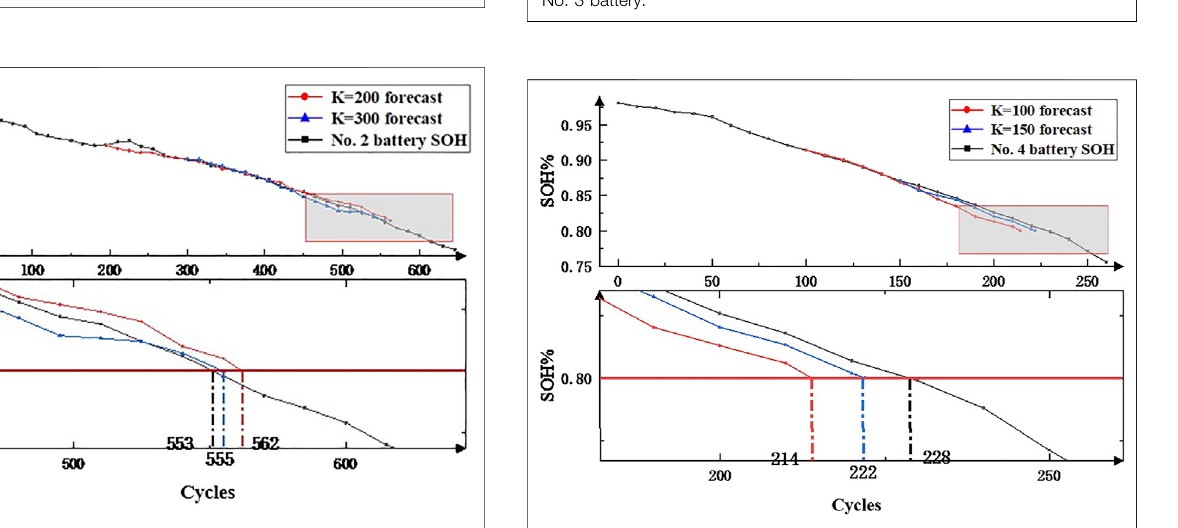
FIGURE 9 | Prediction results of the improved particle fi lter algorithm for No. 4